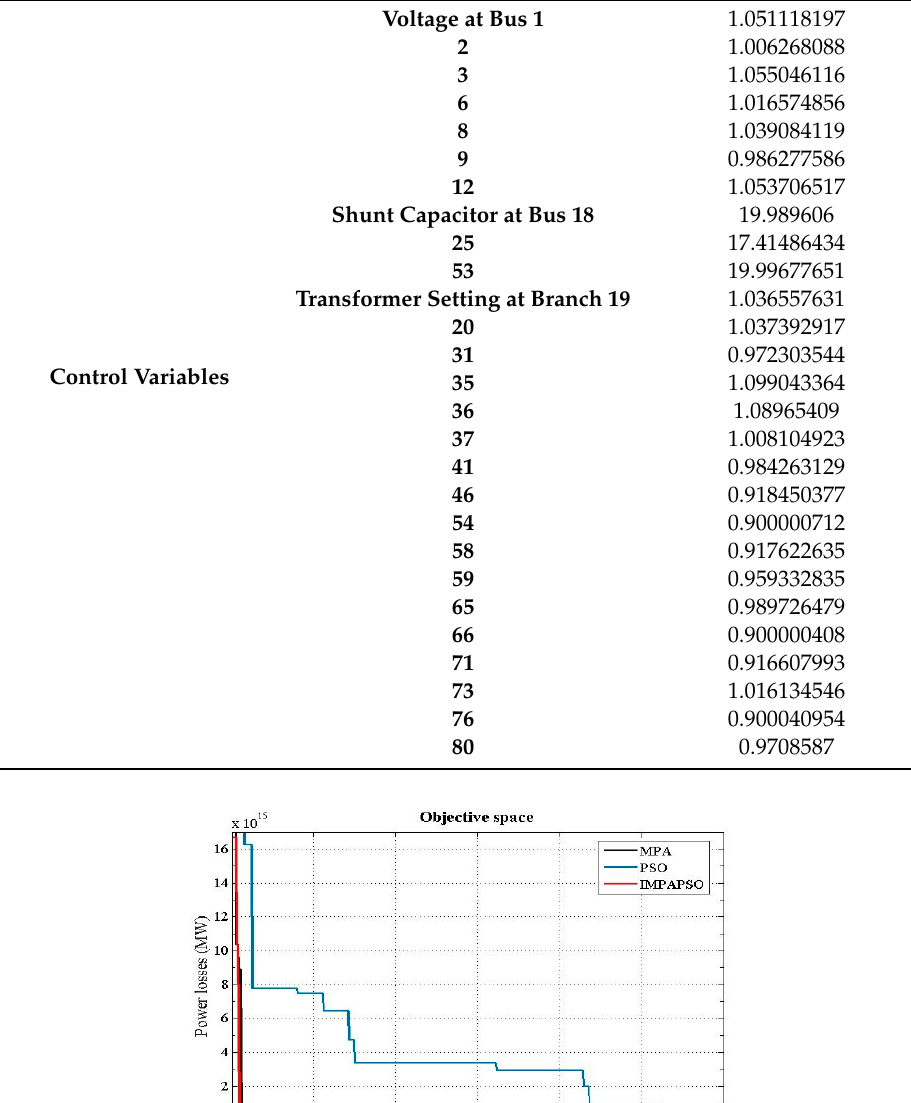
Table 8. 57-bus system decision variables for the second case.